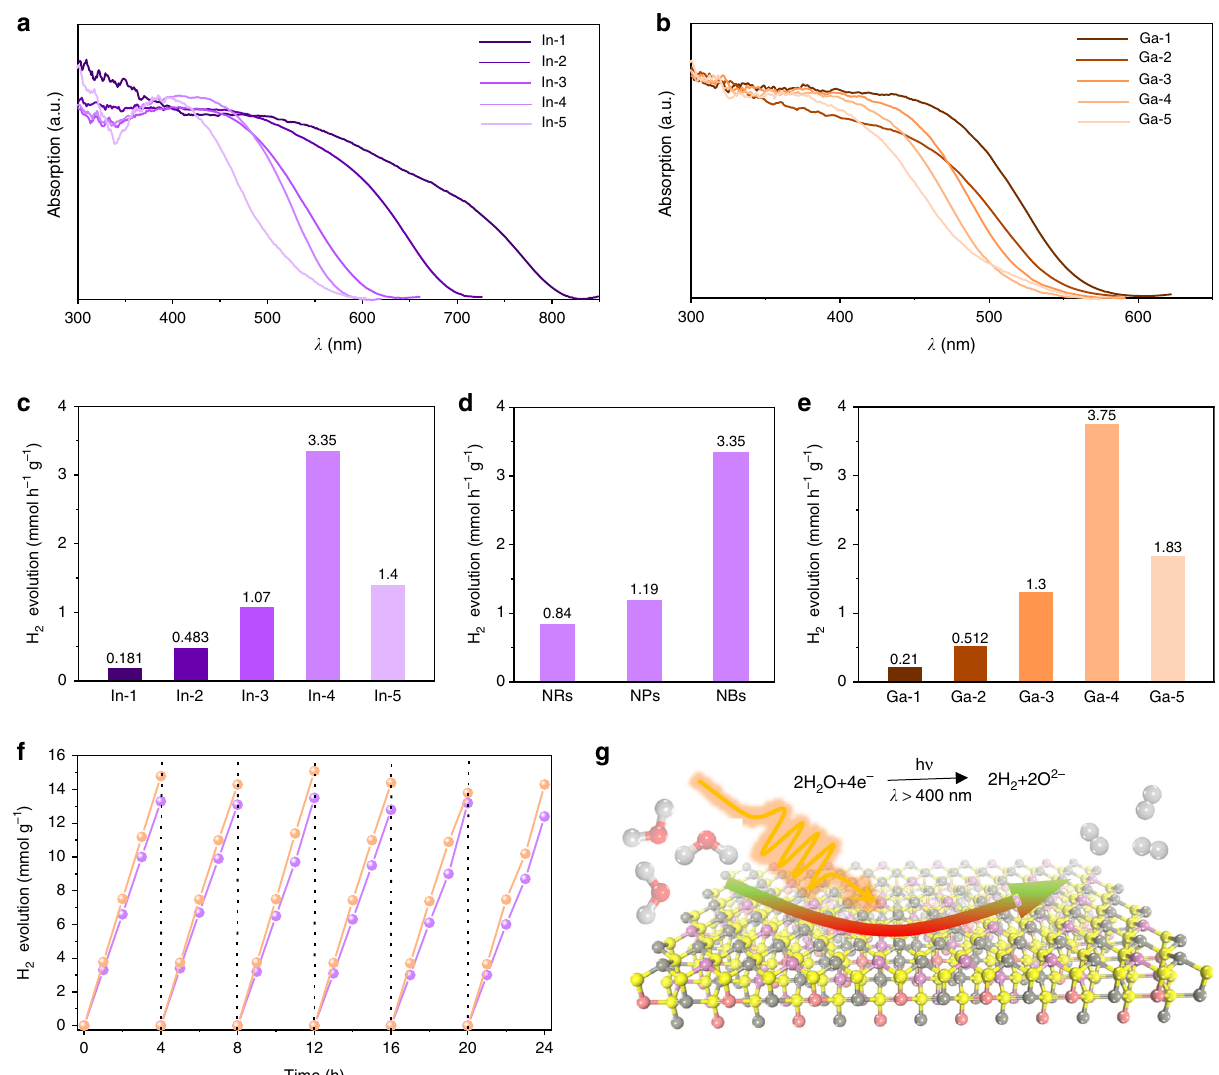
Fig. 4 Optical and photocatalytic performances of the synthesized wurtzite CZIS and CZGS nanobelts. a , b The UV-Vis-IR absorption spectra of CZIS and CZGS nanobelts, respectively. c Comparison of hydrogen production rates using CZIS nanobelt photocatalysts with different Zn contents under visible- light irradiation ( λ > 420 nm). d The photocatalytic hydrogen evolution rates of CZIS nanoparticles, nanorods, and nanobelts with the same composition, respectively. e Comparison of hydrogen evolution rates of wurtzite CZGS nanobelt photocatalysts. f Recycle hydrogen generation property of CZIS and CZGS nanobelt photocatalysts. g Schematic diagram of the photocatalytic hydrogen